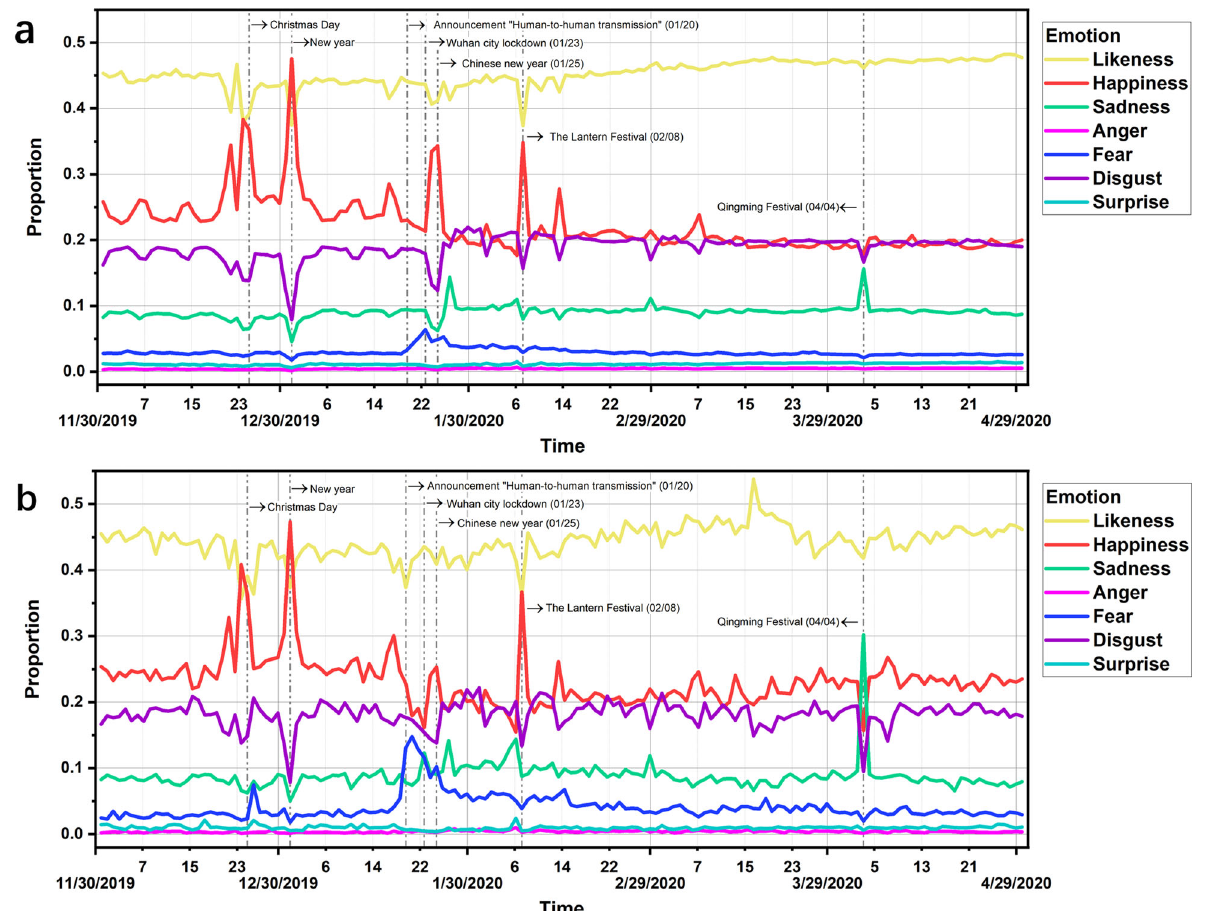
Fig. 1 The emotion distribution over time. The emotion distributions over time during the period from December 2019, to April 2020, a across the whole country, b in Wuhan city. On each day, the proportion value of a certain emotion is the average value of that emotion in all